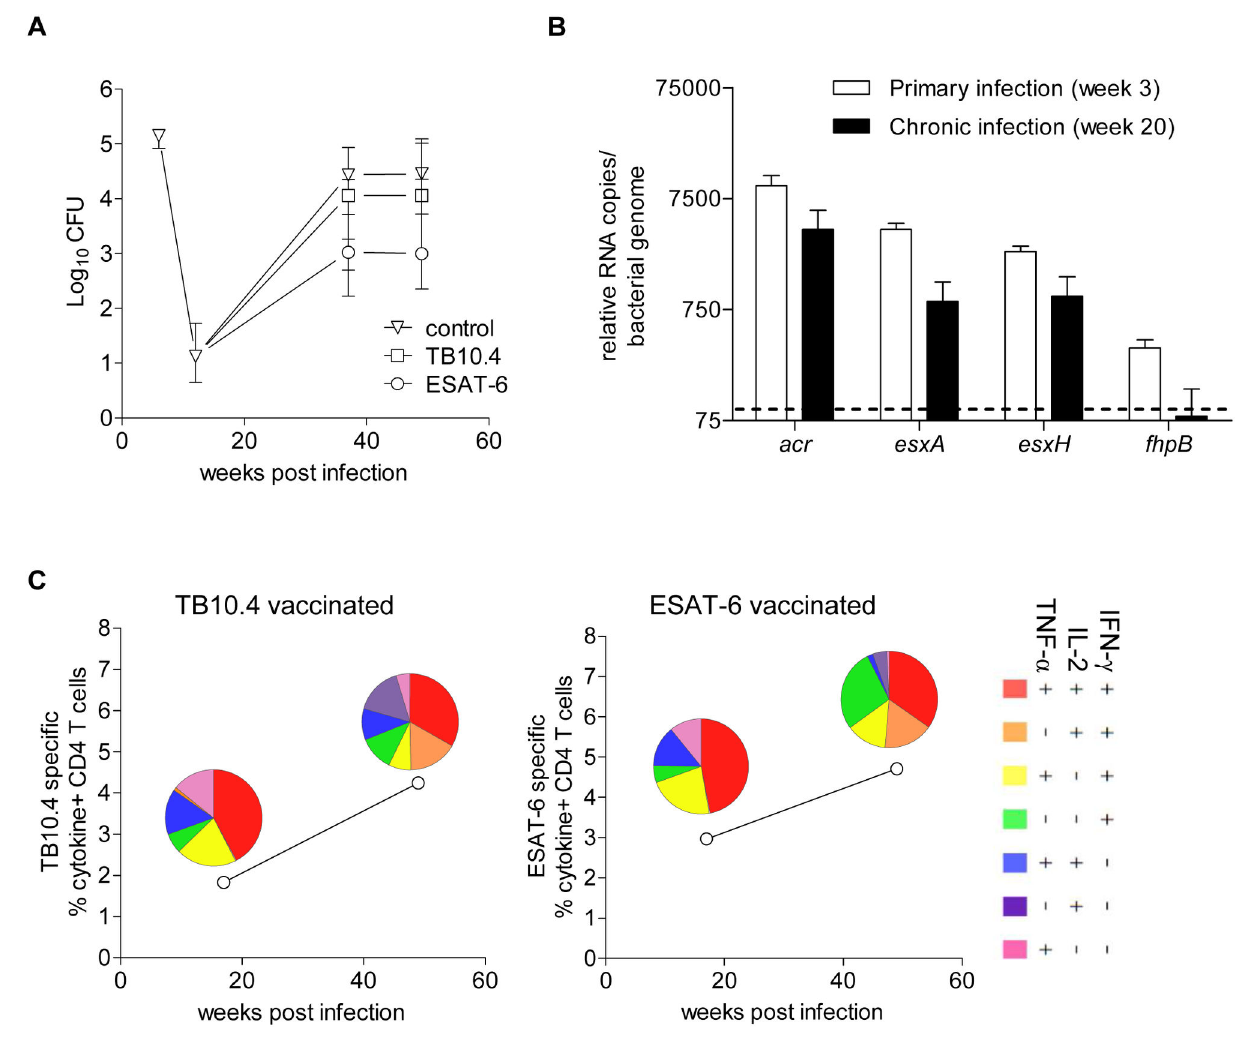
Figure 5. ESAT-6 and TB10.4; gene expression, immunogenicity and post-exposure vaccine efficacy. CB6F1 mice were infected, treated with antibiotics as described above and vaccinated with ESAT-6/CAF01 (n=7), TB10.4/CAF01 (n=7) or CAF01 alone (n=8) at week 10, 13 and 16 post infection (p.i.). (A) At week 37 and 49 p.i. mice were sacrificed, lungs harvested for assessment of protection by culturing lung homogenates at 37° C and enumerating the number of bacteria (expressed as log ). 10 Log CFUs are shown for CAF01 only control animals (open triangles), TB10.4 (open squares) and ESAT-6 (open circles) 10 vaccinated animals. Data are shown as median ± interquartile range and represent 6-8 individual animals. Evaluations of ESAT-6 and TB10.4 have been done in several experiments with similar outcome (the overall dataset is depicted in Figure 6). (B) M.tb . RNA was extracted from lung lobes of CB6F1 mice and used for real-time PCR to assess the gene expression level of the acr, esxA, esxH and fhpB . Data shown as relative transcript numbers (normalized data) and depicts the mean ± standard deviation (n=4). The dotted line denotes the level of detection at 100 relative RNA copies per bacterial genome. (C) Lymphocytes were extracted at week 17 and 49 p.i. from perfused lungs of six pooled mice, vaccinated with TB10.4 or ESAT-6. The cells were re-stimulated with their respective vaccine antigen and stained for CD4, IFN-γ, IL-2 and TNF-α for ICS analysis. Data is displayed as the total frequency of cytokine producing CD4 T cells (producing IFN-γ, IL-2, TNF-α or any combination of the three). The pie-charts represent the proportion of the subpopulation of responding CD4 T cells color-coded according to their cytokine profile. doi: 10.1371/journal.pone.0080579.g005 of adaptive immunity is obviously very different from preventive within granulomas undergo a transition from being vaccination in a naïve host. The hypothesis that has been metabolically active to metabolically inactive i.e. dormant with a rigorously pursued by several groups is that M.tb. contained concurrent shift in transcriptomic profile resulting in so-called